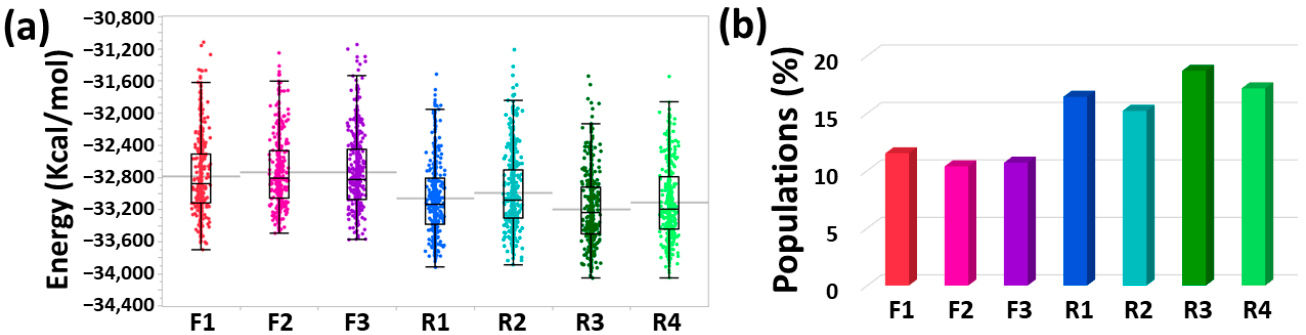
Figure 5. ( a ) Conformational energies computed from the GBMV analysis for all models of the IDE-A β dimers: F1 (color: red), F2 (color: pink), F3 (color: purple), R1 (color: blue), R2 (color: cyan), R3 (color: dark green), R4 (color: light green). ( b ) Populations of all IDE-A β dimer models.